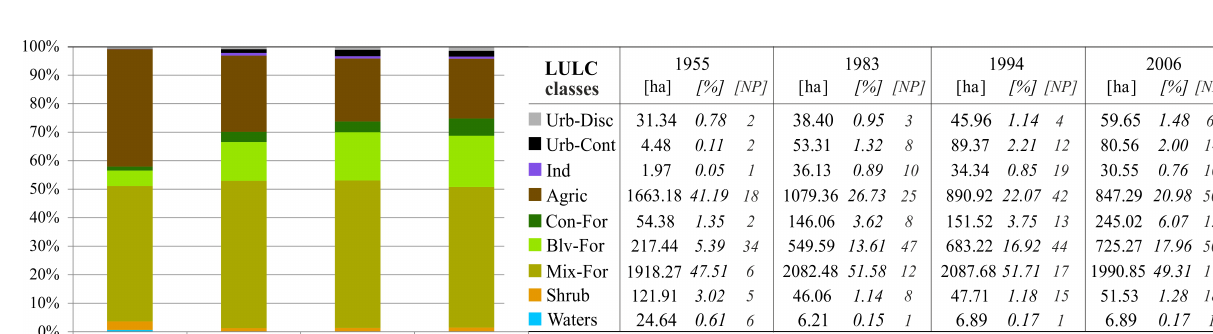
Fig. 4. Landscape composition of the study area in the four time intervals investigated, based on the 9 LULC class types. Data in [ha] and in [%]. In addition, for each LULC class the NP (Number of Patches) is